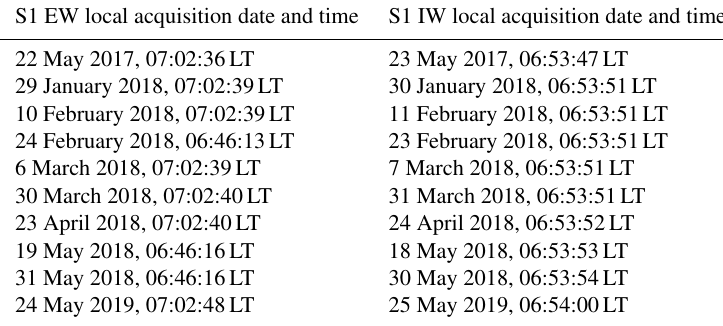
Figure 1. Location of Lake Neyto and visual comparison of potential signs of gas emissions in satellite data. (a) Location of Lake Neyto in the Arctic. (b) Backscatter anomalies are visible as clusters of low backscatter surrounded by regions of much higher backscatter in a Sentinel-1 EW HH-polarised acquisition from 16 May 2016. (c) Regions where snow seems to have melted earlier that appear similar to the regions of backscatter anomalies in the Sentinel-1 image can be seen in a Sentinel-2 true-colour composite from 21 May 2016. (d) Zoomed-in view of a WorldView-2 true-colour composite from 22 May 2016, where holes in the ice are visible as dark spots surrounded by very bright ice. The red rectangle in (b) and (c) indicates the region of the zoomed-in view in (d) . Coordinate reference system (CRS): (a) WGS 84 / Arctic Polar Stereographic, (b) – (d) WGS 84 / UTM zone 42N. Table 2. Local acquisition dates and times of pairs of Sentinel-1 EW and IW scenes used for validation. S1 EW local acquisition date and time S1 IW local acquisition date and